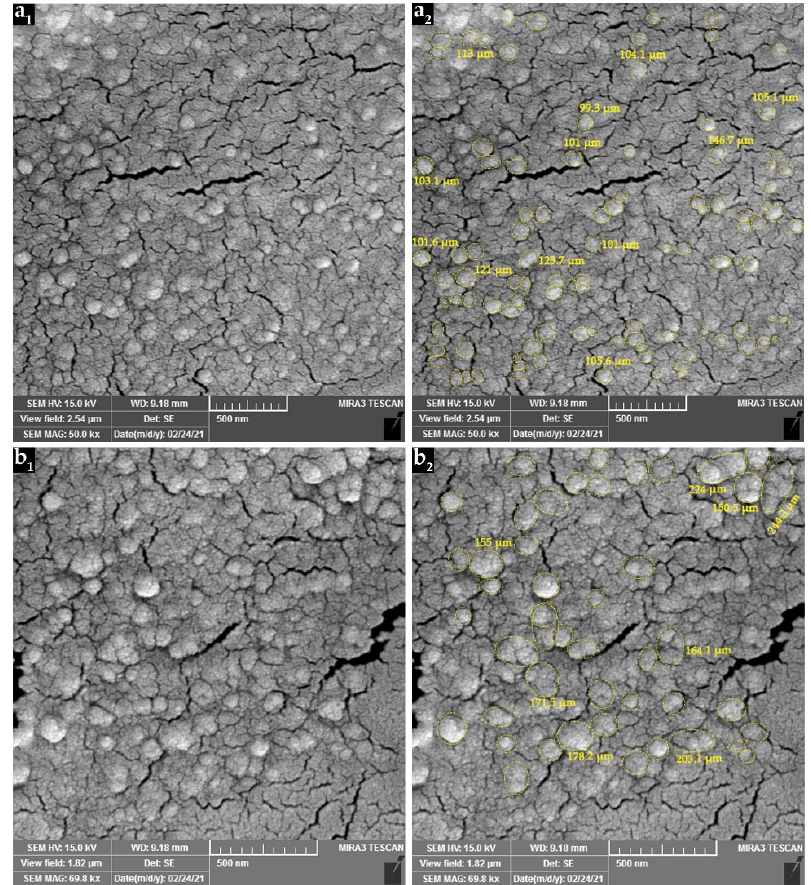
Figure 3. SEM image of ( a 1 ) empty CSNPs, and ( b 1 ) PPE-loaded CSNPs at chitosan:PPE ratio of 1:0.50 ( w/w ). Images ( a 2 ) and ( b 2 ) represent processed figures using ImageJ.